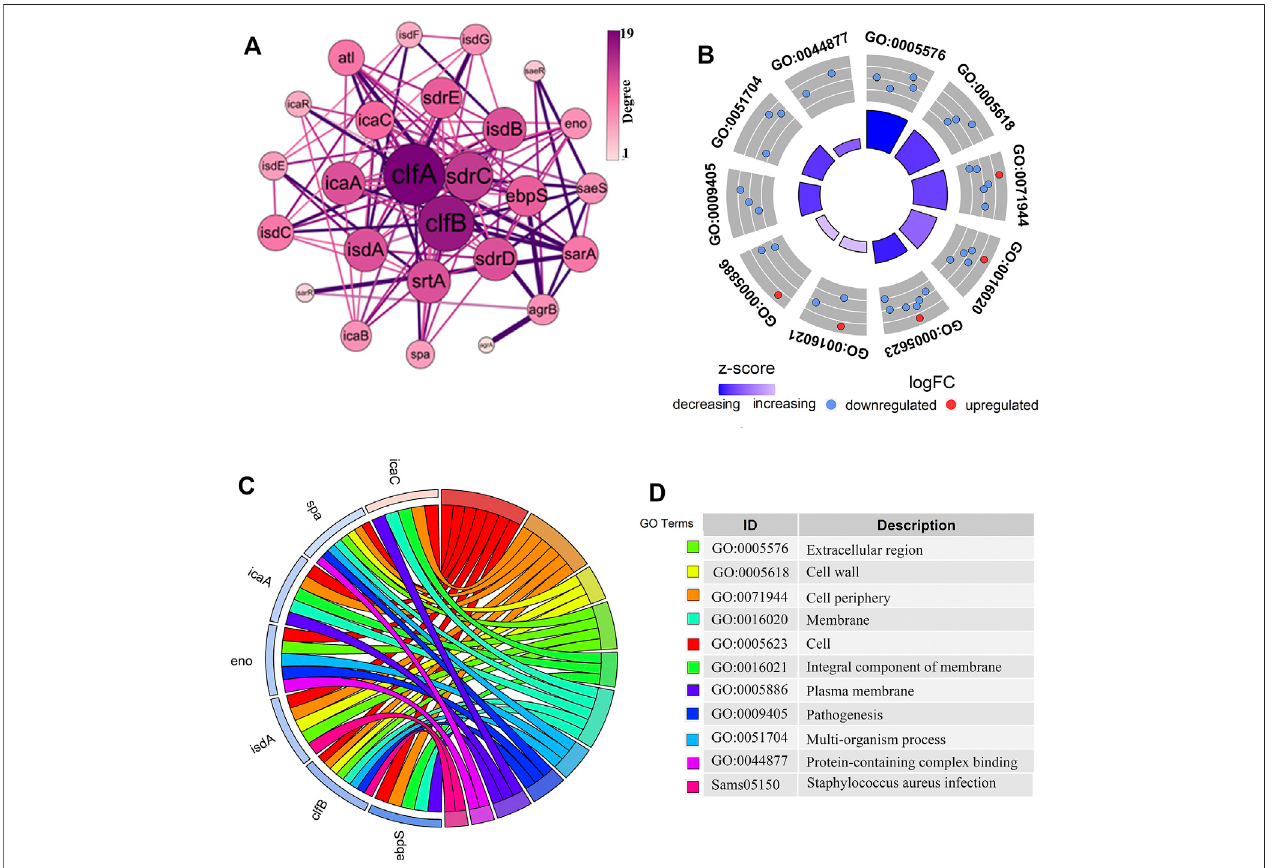
FIGURE 2 | Analysis of the PPI network interactions and the functional enrichment of genes closely related to the bio fi lm formation. (A) . The PPI diagram of 32 genes related to bio fi lm formation, with the size and color intensity of the dotted circles representing the degree value of the genes. The larger circle with a darker color indicates a higher degree as well as a vital position in the network. (B – D) . The gene of interest enrichment analysis plots. The red and blue colors in (B,C) represented signi fi cantly upregulated and downregulated genes. The “ z-score ” represented the upregulated or downregulated status after centralization. The left color in (D) corresponds to the pathway enriched in (C) , and the proper annotation describes the terms in (B,C) .